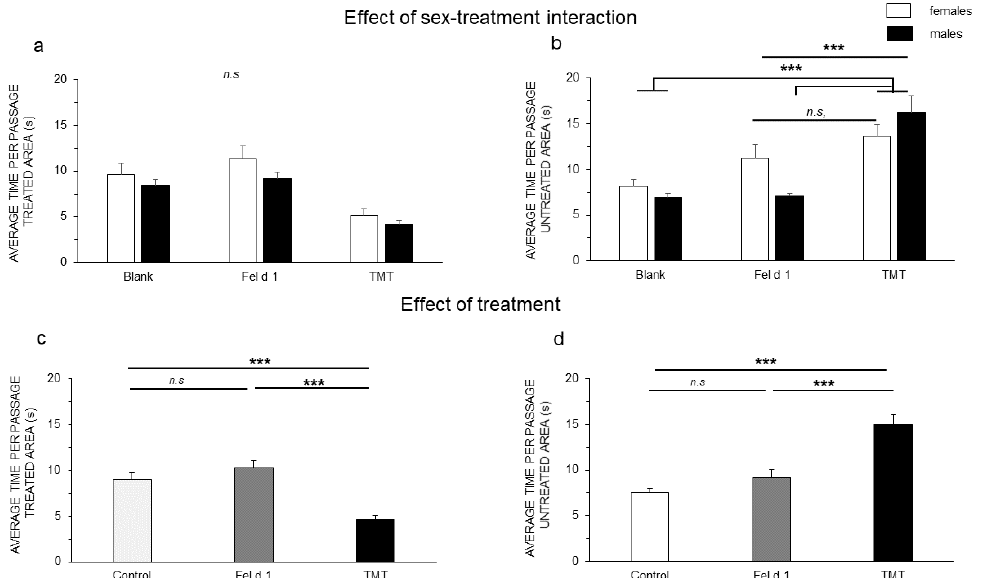
Figure 4. Average time per passage: ( a ) sex-treatment interaction effects in the treated; ( b ) untreated areas. ( c ) Effects of